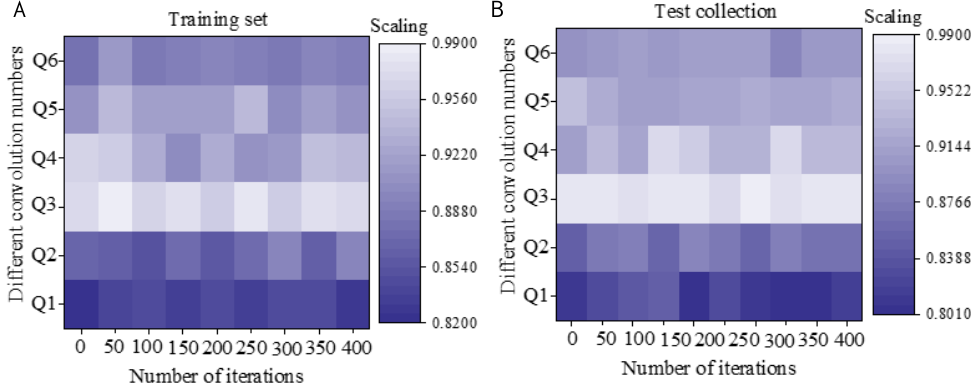
Figure 11. Model accuracy under di ff erent convolution kernels. Figure ( A ) shows the accuracy of the model under di ff erent convolution kernels on the training set; Figure ( B ) shows the accuracy of the model under di ff erent convolution kernels on the test set.